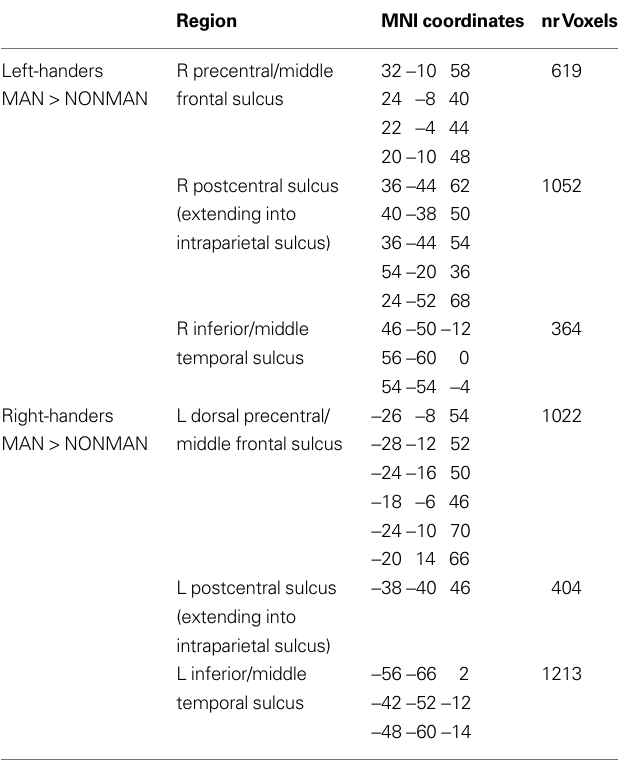
Table 3 | Results from whole brain analysis comparing MAN > NONMAN motor imagery in left-handers (top) and right- handers (bottom). Displayed are an anatomical description of activated areas, the coordinates of local maxima within a region in MNI space and the number of voxels per area (2 mm × 2 mm × 2 mm voxels). Results are corrected for multiple comparisons by thresholding at p < 0.005 and taking the cluster extent into account to arrive at a p < 0.05 corrected p -value.